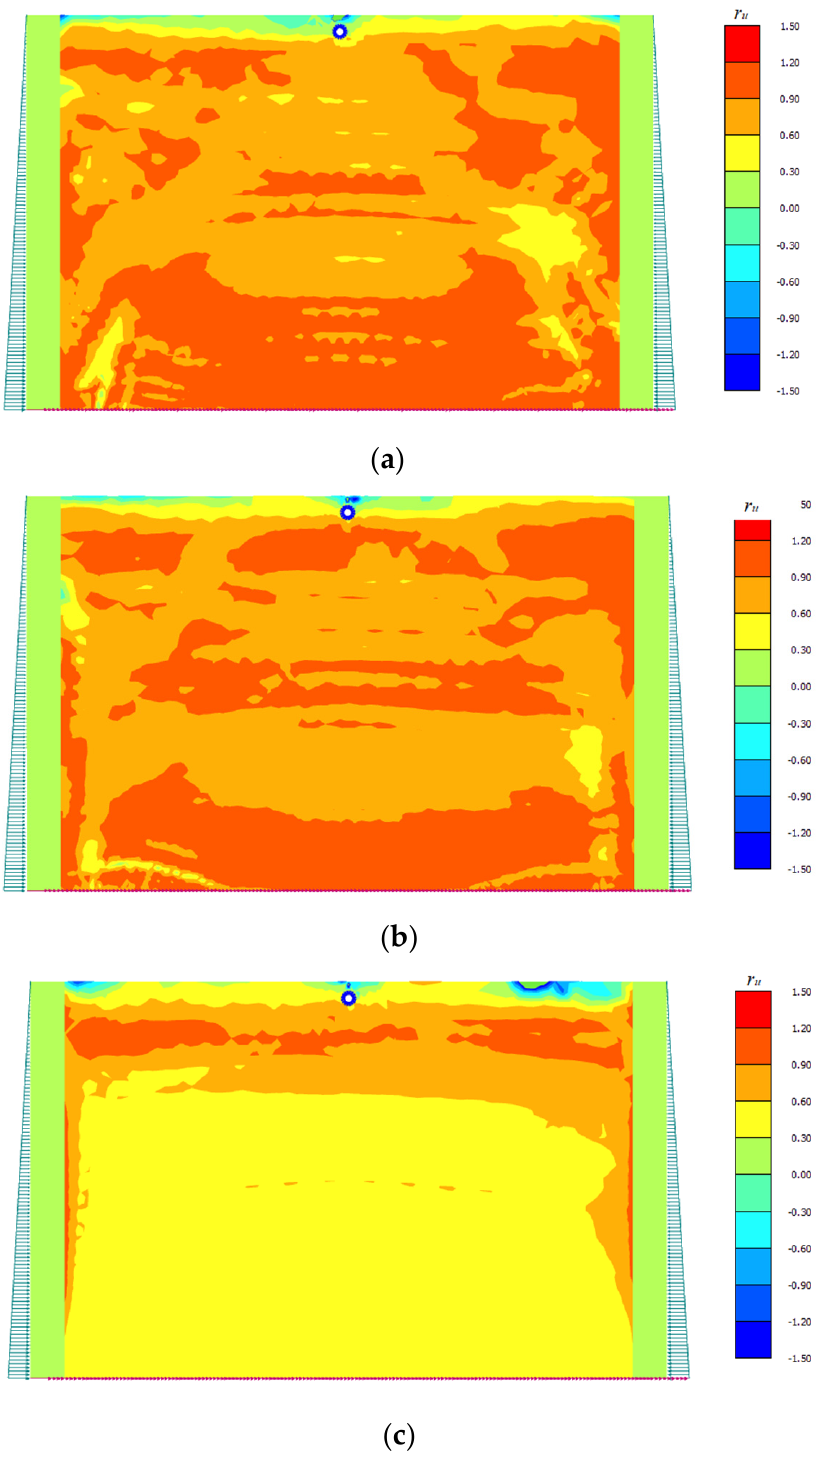
Figure 6. Liquefaction potential of soil under a seismic signal of 1 Hz frequency and 0.1 g amplitude and with a relative density of ( a ) 40%, ( b ) 50% and ( c ) 60%. Finally, the influence of seismic loading on the liquefaction potential of the soil is also explored for three different soil densities, as shown in Figure 6. It can be observed that, for the same earthquake signal (with a 0.1 g amplitude and a 1Hz frequency), the pore water pressure ratio is higher in the soil with a 40% relative density, in comparison to the case with a 60% relative density soil. From Figure 6a, it can be seen that for the 40%